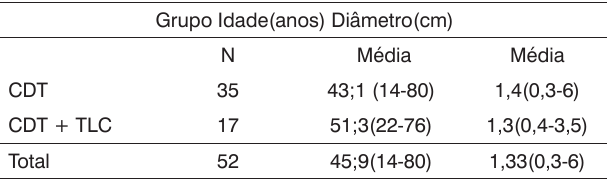
Tabela 4. Comparação dos grupos com relação à idade dos pacien- tes e ao diâmetro do